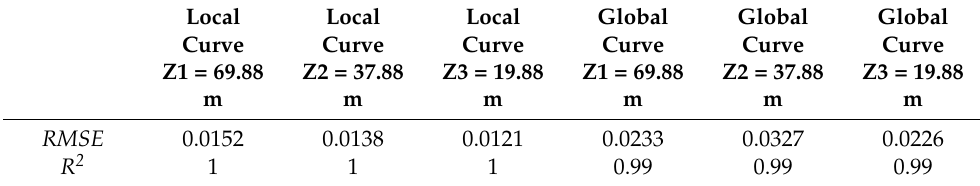
Table 4. Curve model quality evaluation result.